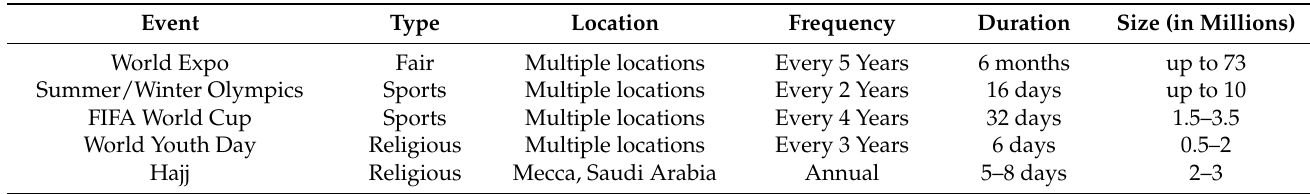
Table 1. List of various types of global mass